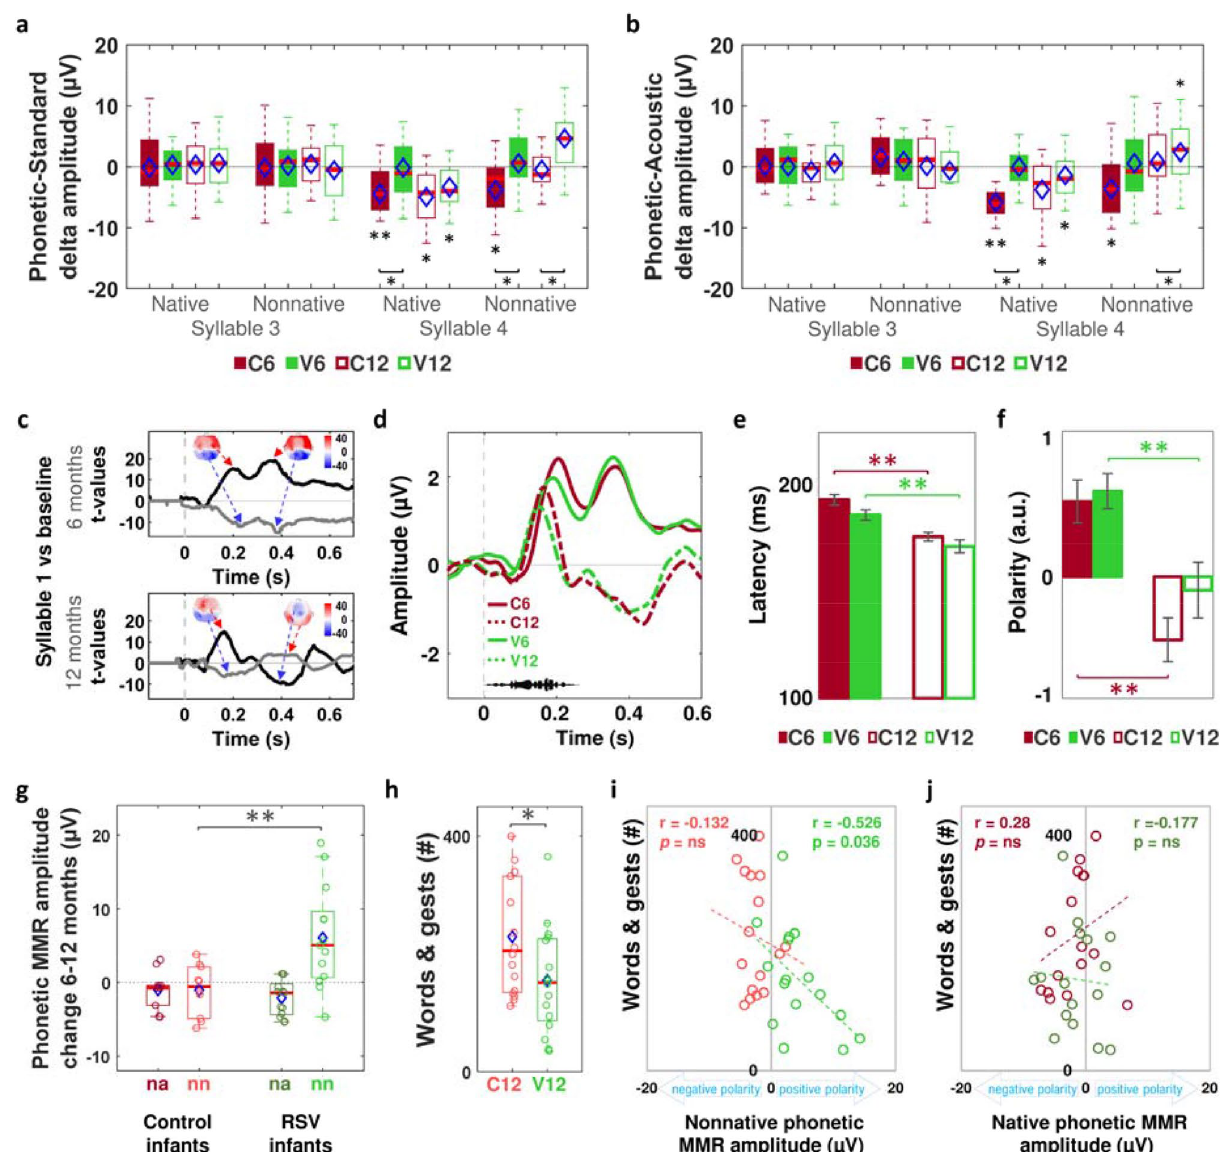
Figure 3. The V6 and V12 groups showed atypical phonetic MMR and fewer linguistic skills than the control groups. In ( a ) we depict the boxplots of the phonetic MMR for the native and nonnative contrasts, at syllable 3 and 4 per group. Red horizontal lines and blue diamonds correspond to the median and the mean of each group, respectively. Error bars indicate 95% confidence interval. The asterisks adjacent to the boxplots indicate significant differences from zero at p < 0.05, while the asterisks below the braces indicate significant differences between groups at the extremes of the braces. In ( b ) we plot the boxplots for the difference in amplitude between phonetic and acoustic trials, to extract the linguistic component of the phonetic MMR. In ( c ), we depict the t -map for the electrodes and t -values for the time window at the frontotemporal (black line) and parieto- occipital electrodes (grey line), over which the brain response for the syllable 1 differed from the silent baseline at 6 and 12 months of age. In ( d ) we plot the time course of the grand average for the syllable 1 per group and age, computed over the spatiotemporal windows at the frontal electrodes. We illustrate in ( e ), the mean of the first peak’s latency and in ( f ), the mean of the second peak polarity per group. We depict in ( g ) the difference in amplitude of the mean phonetic MMR between 6 and 12 months of age, in a subsample of infants evaluated at both ages, nn = nonnative; na = native. In ( h ) we depict the sum of words and gests understood and used by infants of the C12 and V12 groups, reported by their parents. In ( i ) and ( j ) we plot the correlations of the mean sum of words and gests handled by the infants against the phonetic MMR amplitude for the nonnative and native phonetic MMR, respectively, in C12 (red circles) and V12 groups (green circles). Pearson’s correlation coefficient and p -value are indicated for each